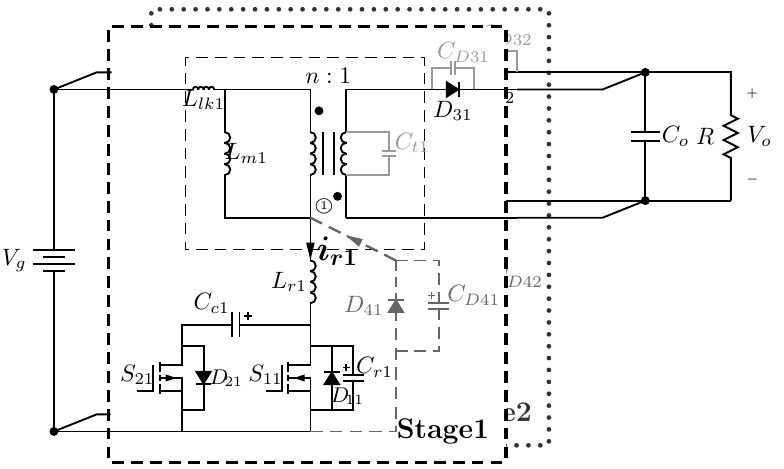
Figure 10. Connection diagram of the prototype that was formed of two stages in